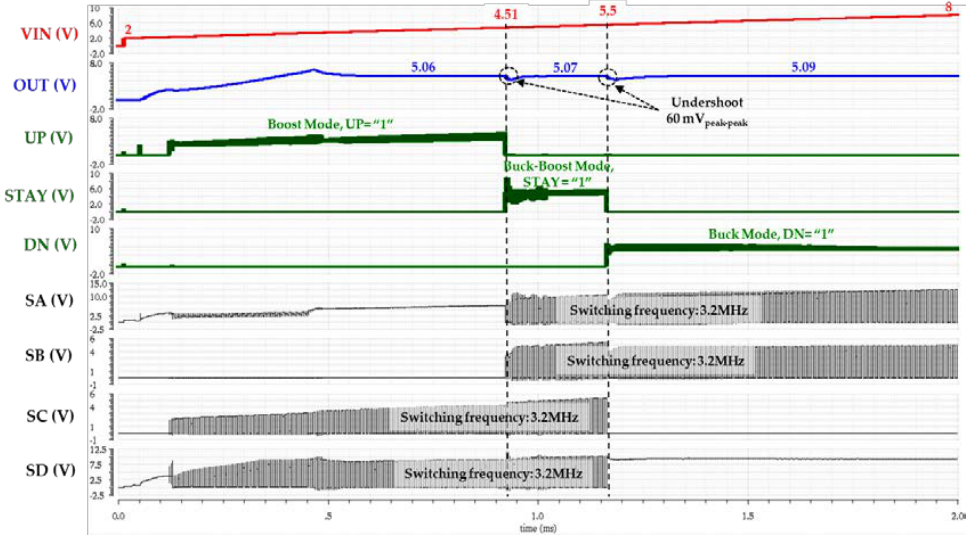
Figure 9. Top simulation of the proposed buck-boost DC–DC converter.